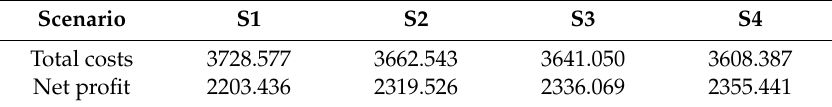
Table 9. System total costs and net profit in di ff erent scenarios (Unit: